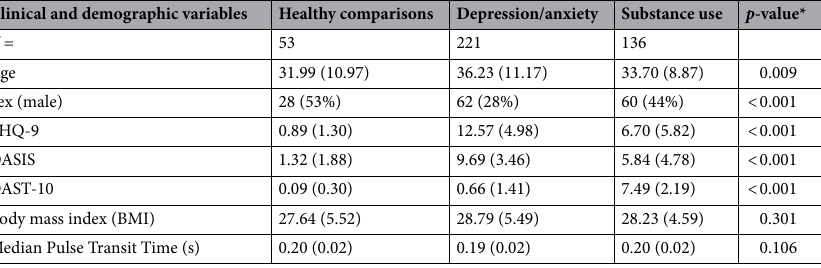
Table 1. Mean and standard deviation for clinical and demographic variables. * p -values correspond to the results of ANOVAs comparing the three